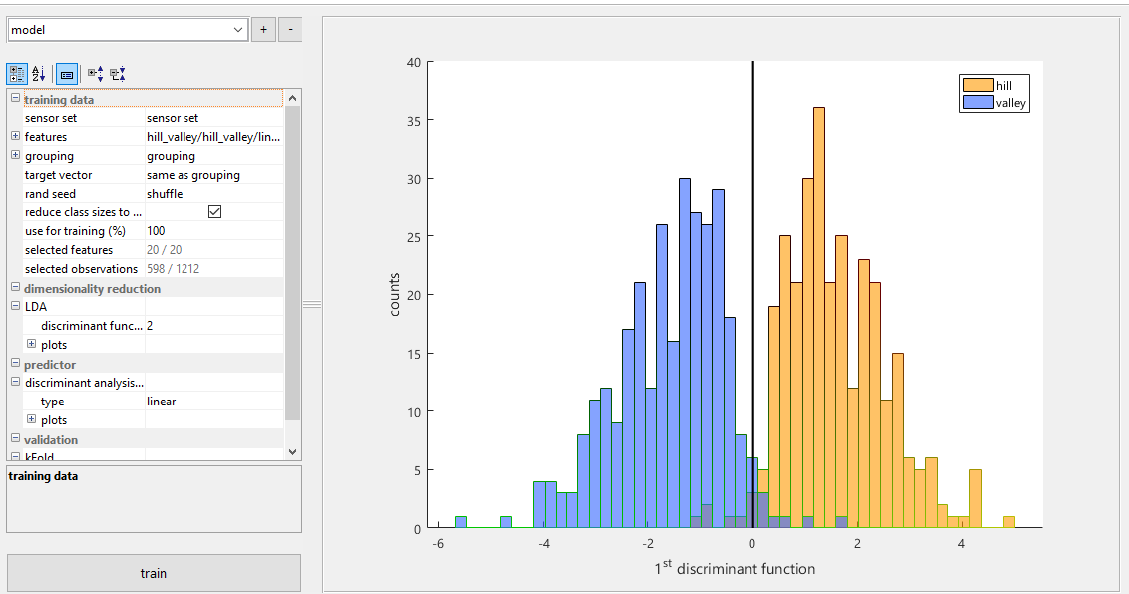
Figure 9. The model module provides the possibility to exclude features or observations from the training data to see their influence on the model. In this image, the model consists of a 2-D LDA with a linear DA classifier which is validated with 10-fold cross-validation. The data distribution resulting from the dimensionality reduction is shown, with class information, as a